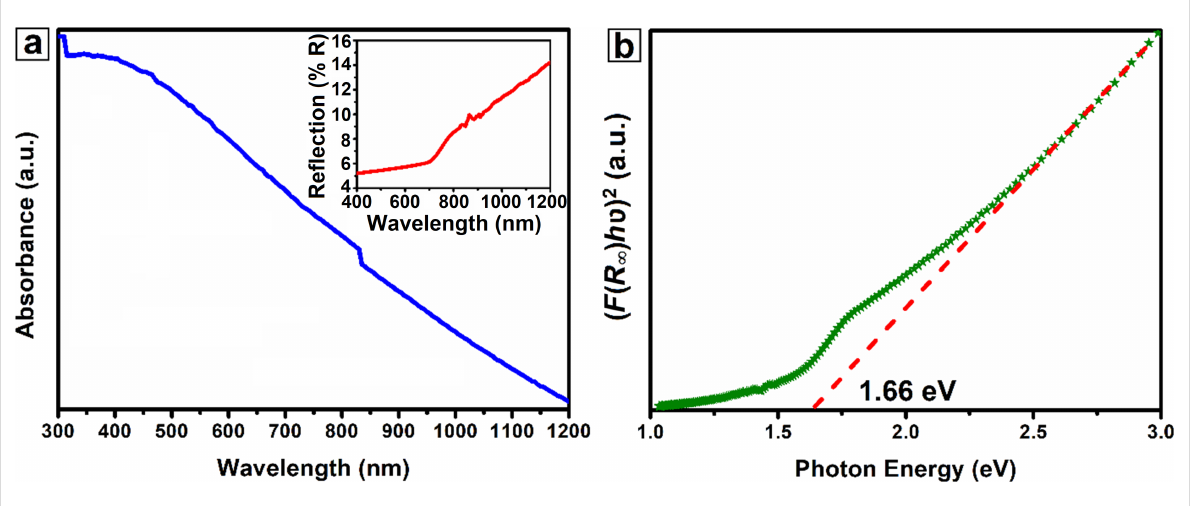
Figure 3: (a) Absorbance spectroscopy graph (inset figure: diffuse reflectance graph) and (b) bandgap energy diagram of CuNiCoS 4 nanocrystals.